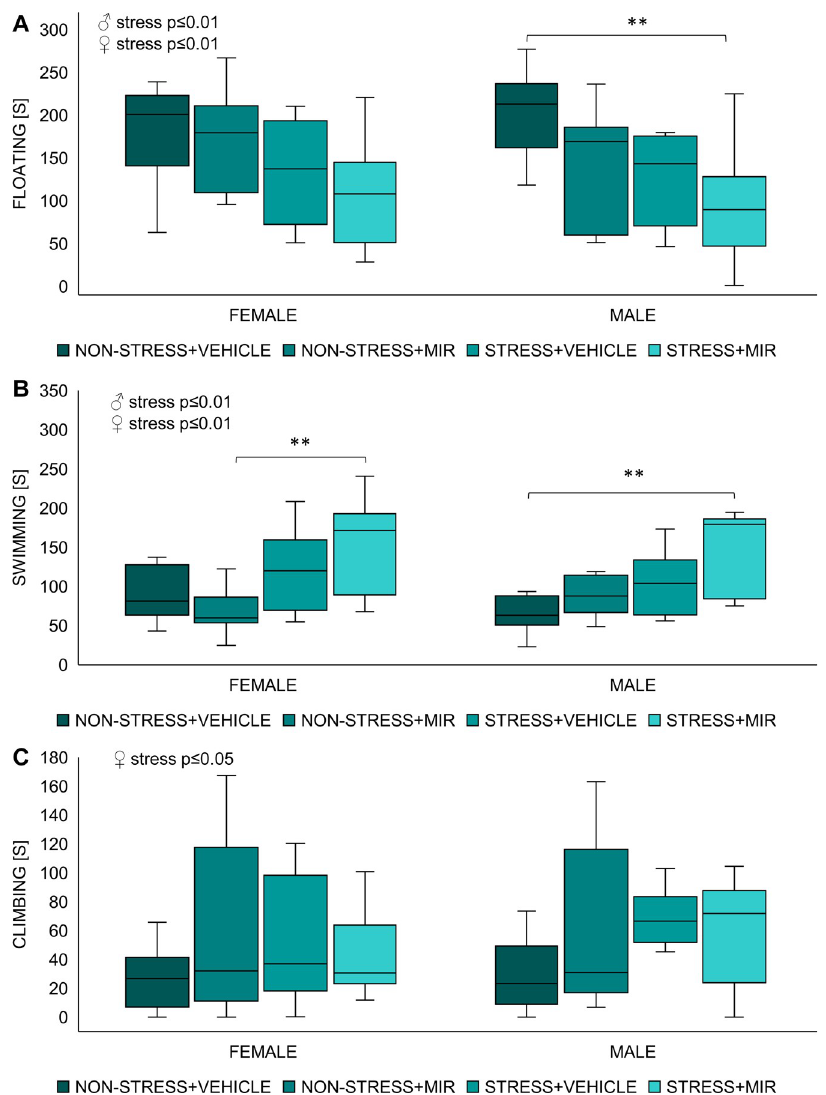
Fig 8. Forced swim test of adolescent offspring. (A) time spent floating, (B) time spent swimming, (C) time spent climbing. n = 7–11 animals/group/sex. �� p � 0.01.